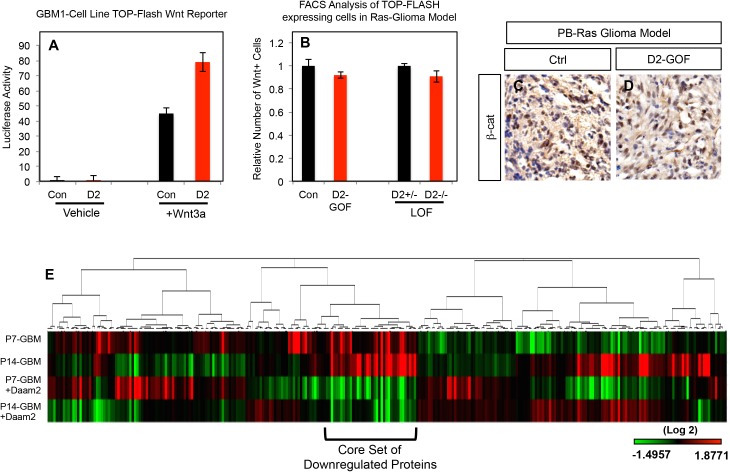
Daam2 effect on Wnt signaling in glioma and RPPA analysis.(A) Luciferase reporter assay using Wnt reporter (TOP-Flash) in GBM1 cell lines. Cell line was transfected with Daam2, GFP control, with and without Wnt3a, and the TOP-FLASH reporter to measure Wnt activity. Note that Daam2 alone does not activate Wnt reporter; activation by Daam2 requires presence of canonical Wnt ligand, Wnt3a. Activation by Daam2 in the context of Wnt3a is very mild ~ 1.8 fold. Each experiment was performed in triplicate, with three replicates for each group. (B) FACS analysis of the relative number of TOP-FLASH-BFP expressing cells in our PB-Ras model. We performed IUE with the PB-Ras model and included Daam2 overexpression (GOF) along with the TOP-FLASH-BFP construct. In addition, we generated PB-Ras glioma in our Daam2 ± and Daam2-/- mice (LOF) that were also electroporated with the TOP-FLASH-BFP reporter. At post-natal day 12, tumors were harvested, dissociated and subjected to FACS analysis, where we assessed the relative number of BFP+/GFP + cells within the tumor as an index of Wnt activity across the respective experimental conditions in both the GOF and LOF studies. (C–D) Representative immunohistochemistry staining of PB-Ras, Daam2-GOF tumors with β-catenin antibodies. This analysis was performed on six different tumors for each condition, four slides per tumor. (E) Heatmap representation of median centered unsupervised hierarchical clustering of RPPA protein expression analysis from P7 and P14 PB-Ras glioma subjected to Daam2-GOF. Please see Supplementary file 1 for the raw data and the methods section for additional details. Note that the bracket denotes a core set of proteins that are downregulated in the presence of Daam2. These proteins are featured in Figure 4a.